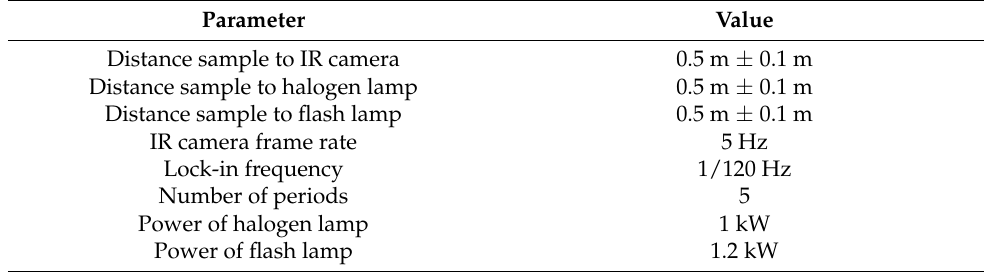
Table 2. Specification of the parameters used for lock-in thermography. Parameter Value Distance sample to IR camera